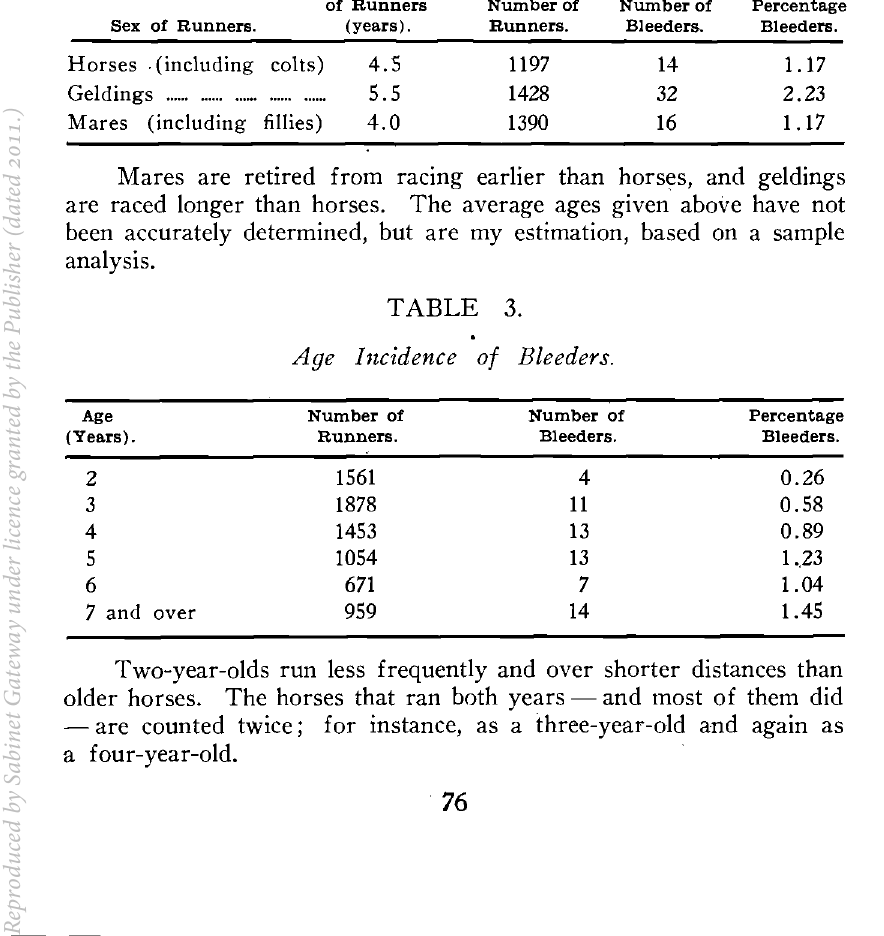
Sex Incidence of